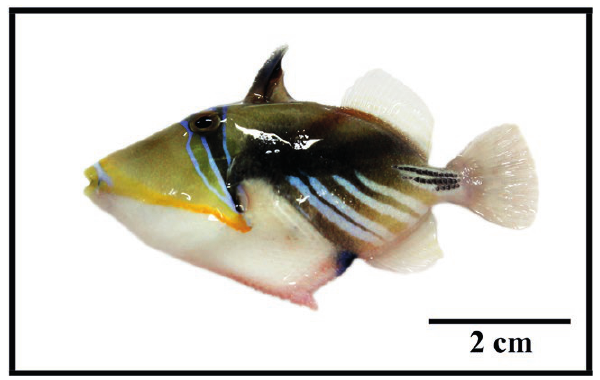
Figure 1. General characteristic of Rhinecanthus aculeatus , its respective collection sites in the Indian (Andaman Sea) and Pacific Oceans (Gulf of